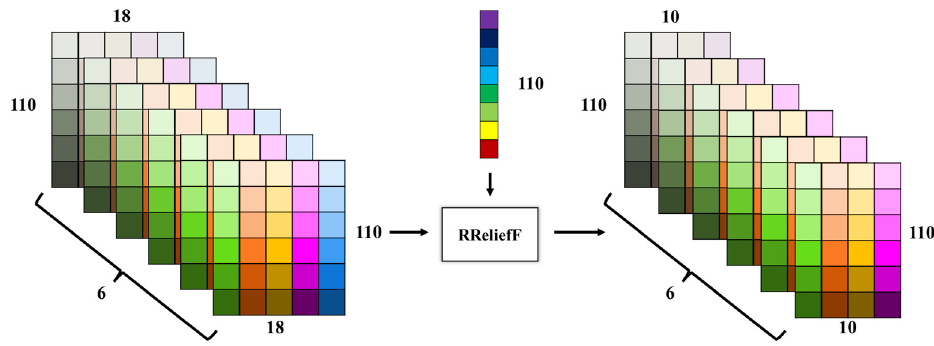
Figure 2. Method of obtaining the optimal vegetation indexes using the RReliefF algorithm.